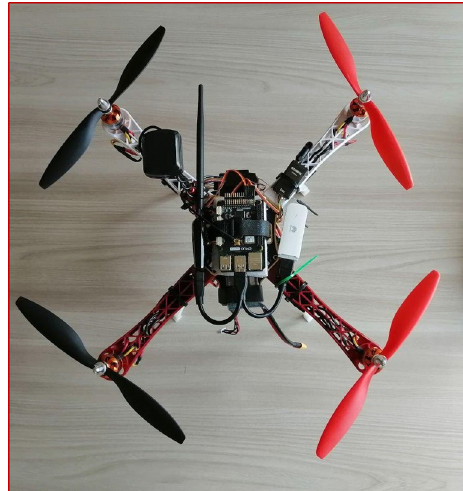
Figure 8. Top-view of the drone